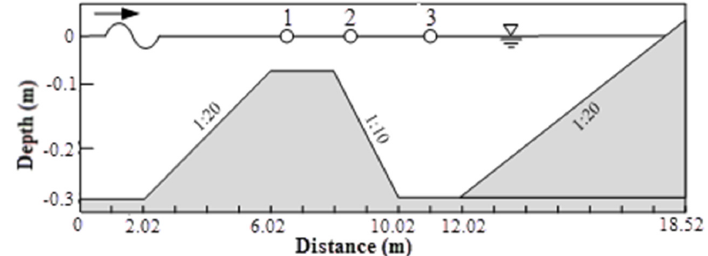
Figure 11. Sketch of the experimental setup of Nadaoka.